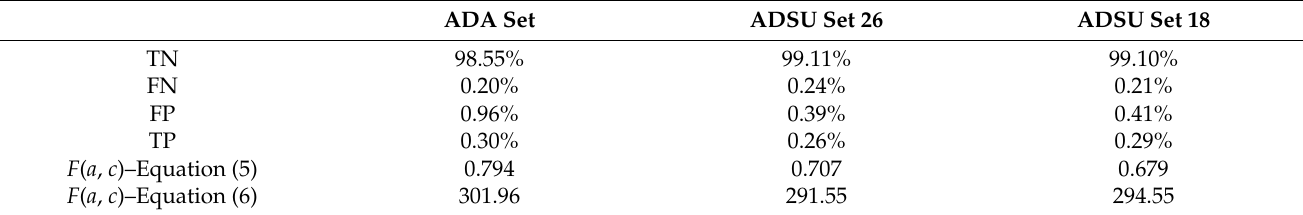
Table 2. Confusion matrices and values of the metrics defined by Equations (5) and (6) for three different outputs: the active deformation areas (ADAs) mapped by means of the so-called ADAFinder software package [29], the active deformation slope unit (ADSU) set 26, corresponding to the minimum value of the metric F ( a, c ) defined by Equation (5), and the ADSU set 18 (optimal ADSU set), corresponding to the minimum value of the metric F ( a, c ) defined by Equation (5). TN: true